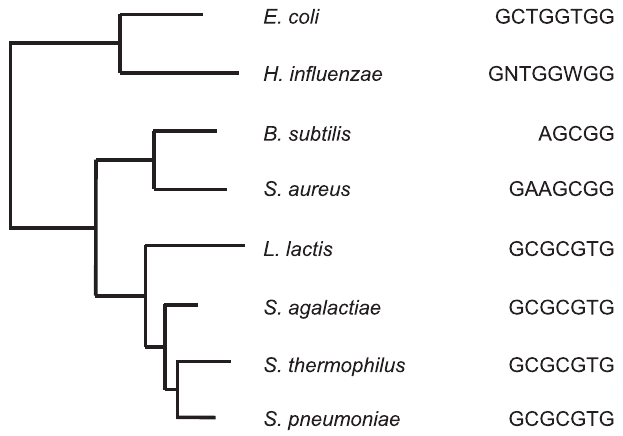
Figure 3. Chi Sequence Conservation through Evolution The tree shows phylogenetic relationships of the eight bacterial species in which Chi is known, based on 16S RNA, and was constructed using the tree-builder command of the Ribosomal Database Project (https://rdp. cme.msu.edu/). E. coli, H. influenzae, L. lactis, and B. subtilis Chi sites were previously identified [5,25,26]. Chi sites of S. aureus and the three streptococci were identified by predictive modeling and confirmed experimentally (this work). Partial conservation of Chi correlates with phylogenetic conservation among